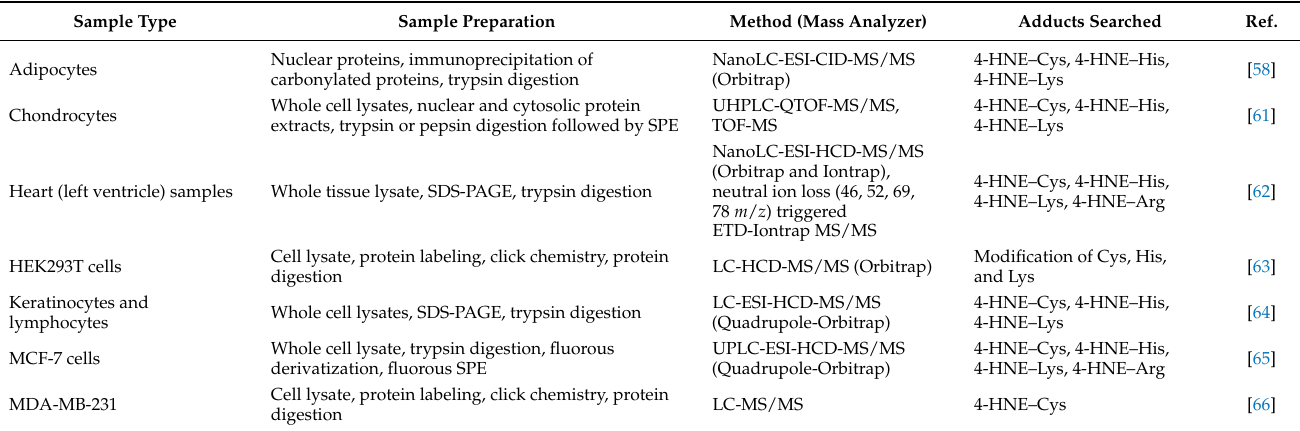
Table 2. Analysis of 4-HNE–protein adducts in complex samples by mass spectrometry. Sample